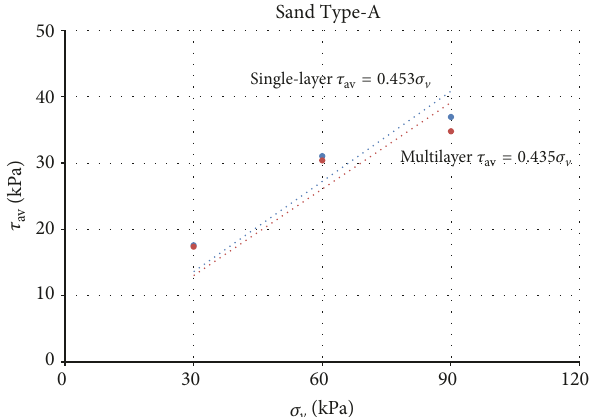
Figure 10: Relation curve for confining stress relative to pullout friction stress of Type-A reinforcement.